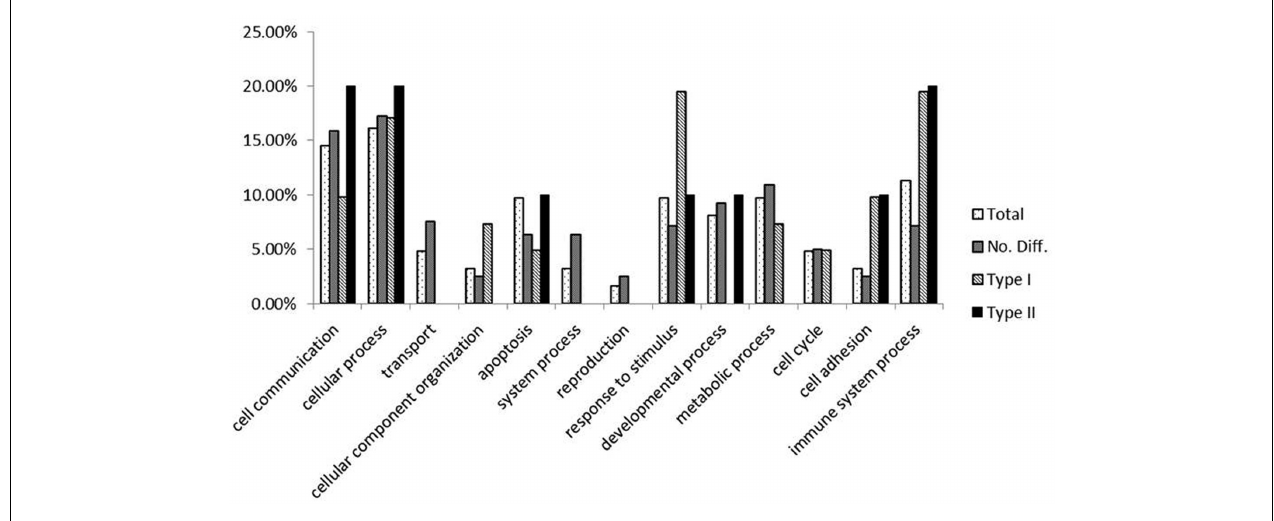
FIGURE 3 | Functional analysis of the genes by